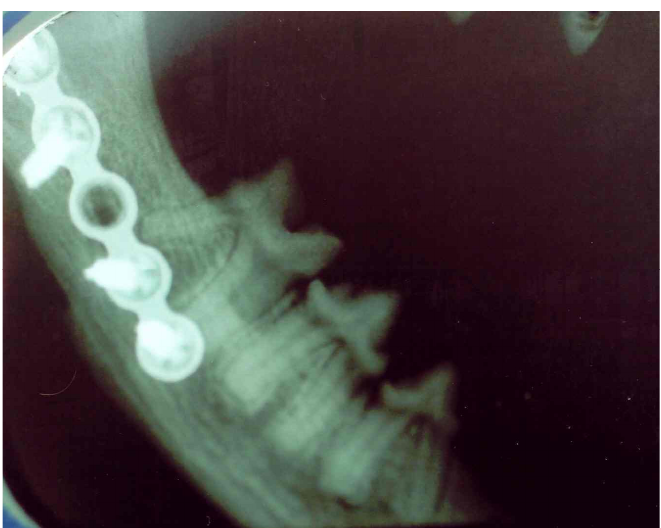
FIGURE 6 - Intraoral radiograph taken 12 weeks after surgery. Bone healing as manifested by obliteration of the osteotomy line. Cat 5 of Group 1.